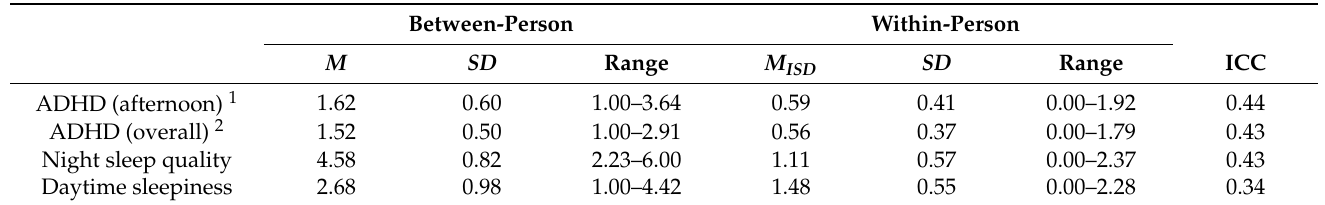
Table 1. Descriptive statistics for children’s ADHD symptom levels, night sleep quality, and daytime sleepiness across all 54 study days.